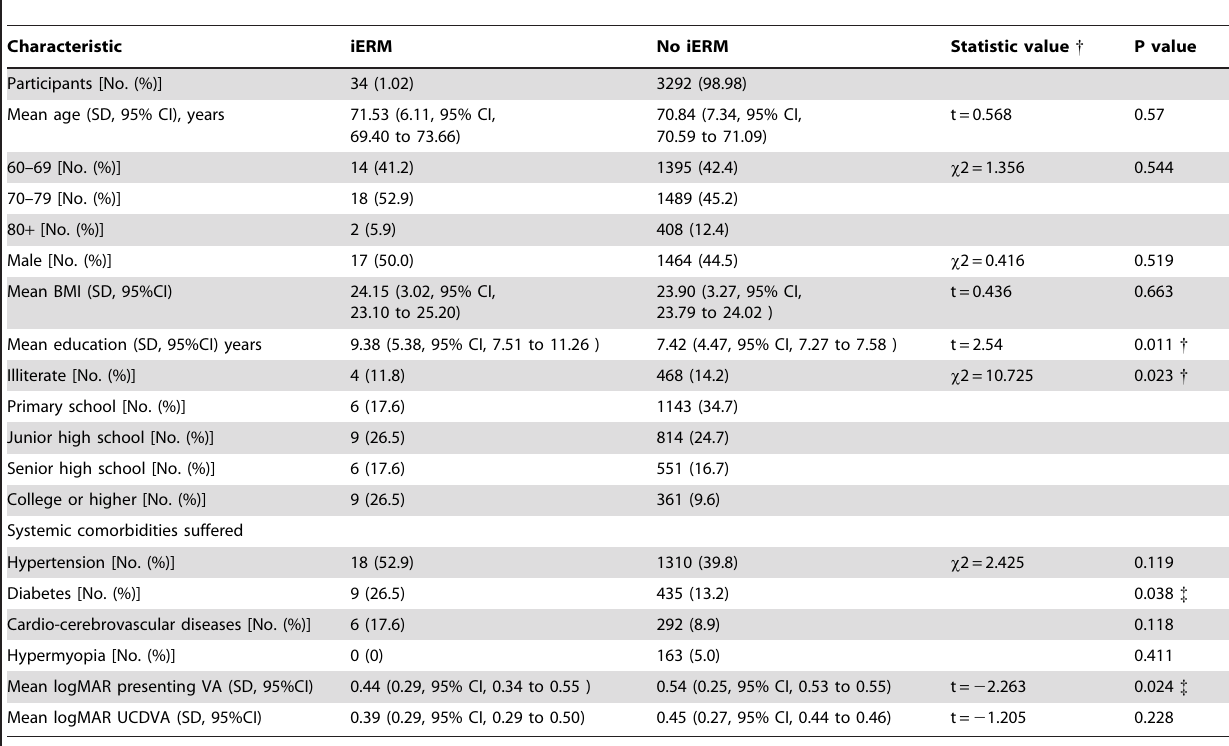
Table 2. Demographic and clinical characteristics among the participants (n=3326) with or without idiopathic epiretinal membrane.*